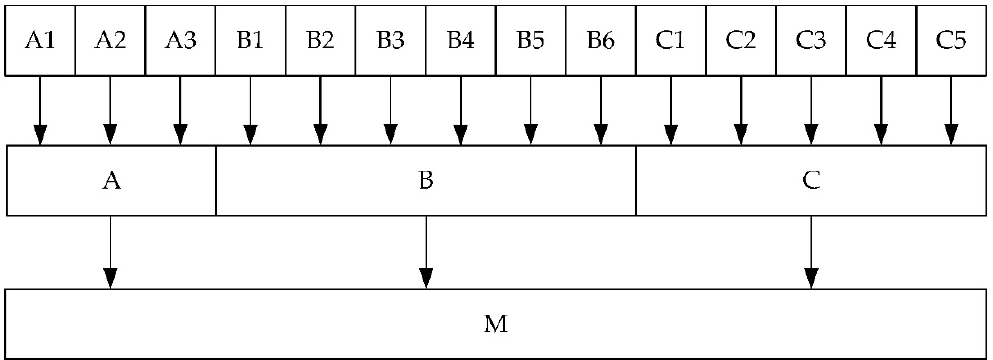
Figure 4. Hierarchical structure of fuzzy composition.